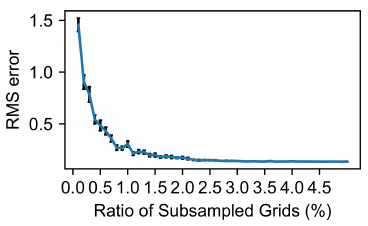
Figure 11. Results of the inverse analysis for the subsampled test datasets. The values of RMSE are averaged over 20 iterations. Error bars indicate standard errors of RMSE